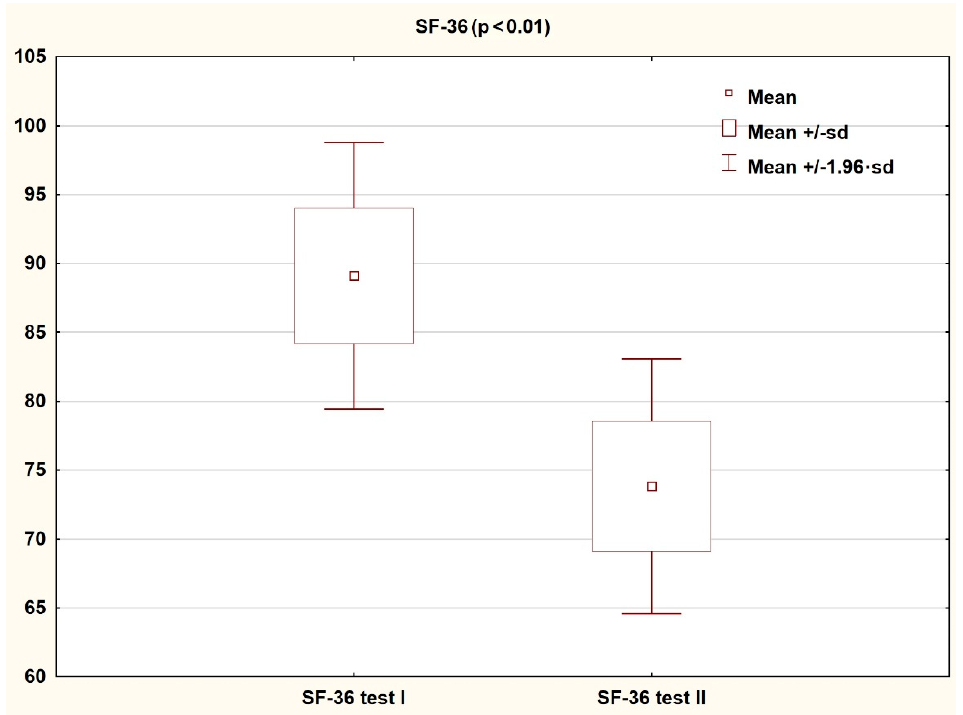
Figure 5. Patient results in the SF-36 scale during the first and second study (Student’st-test for dependent variables).